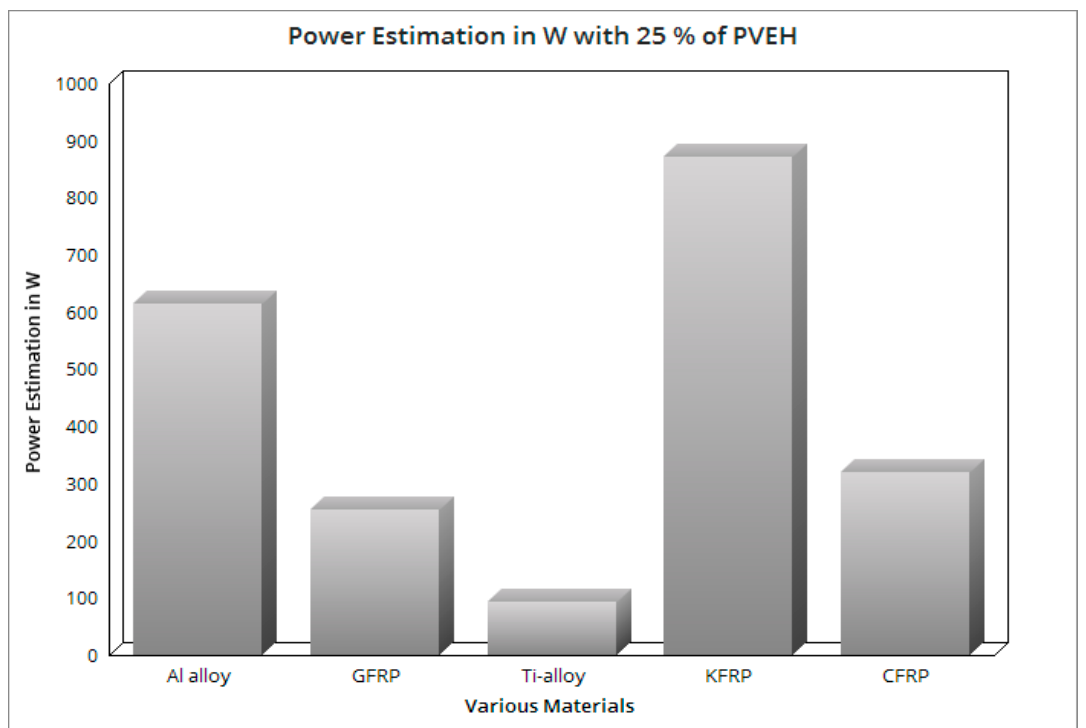
Figure 38. Power (P 0 ) in W with 25% attachment coverage—wind turbine blade.